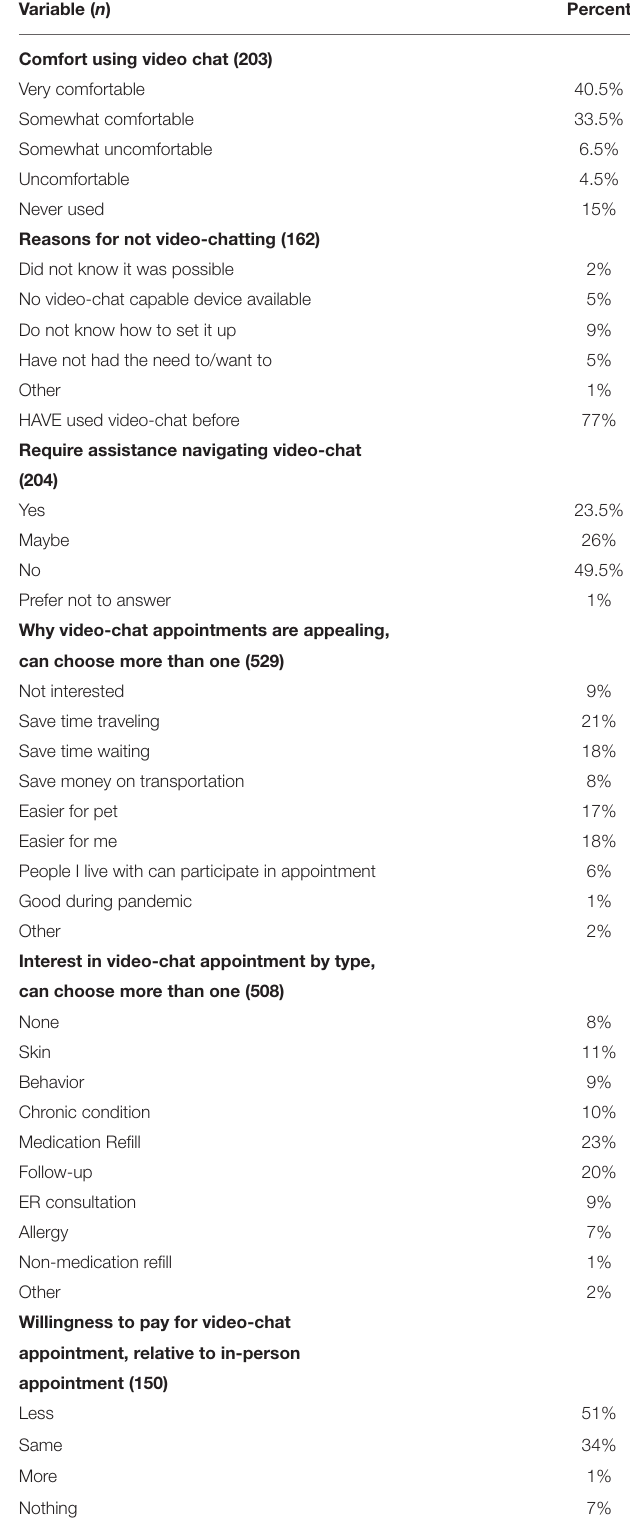
TABLE 3 | Digital Access Survey Responses from 205 Clients of a Low-Cost Veterinary Clinic in Worcester, MA. Variable ( n )